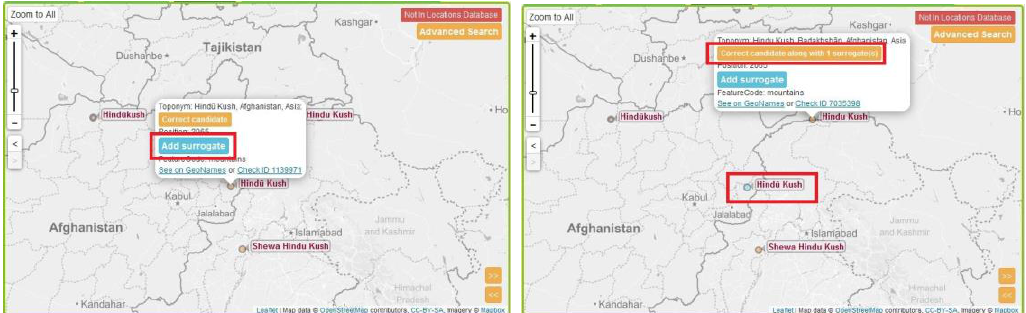
Figure 13. Adding surrogates to a place name. Users can assign more than one toponym to a single place name. The “not in locations database” button allows users to specify that a place name is not in the gazetteer.